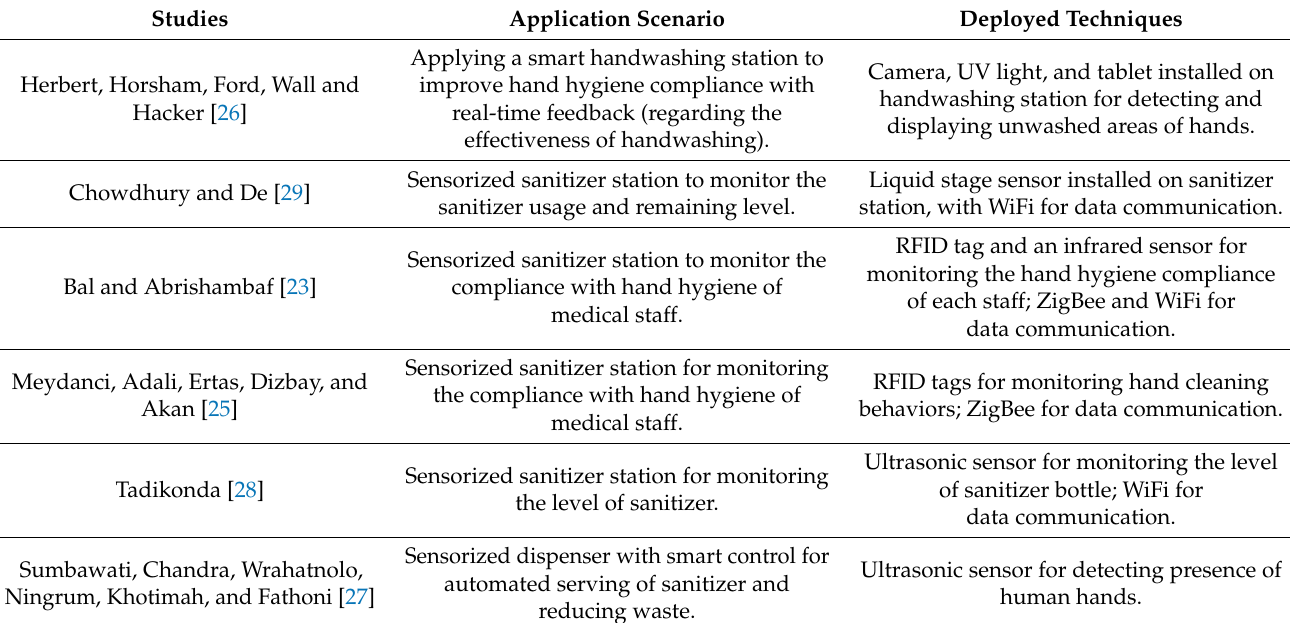
Table 1. Review of related studies.